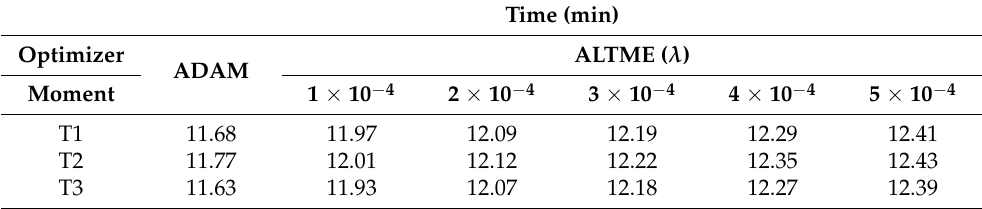
Table 9. Runtime of the ALTME optimizer cumulative learning weight adaptive selection experiment.